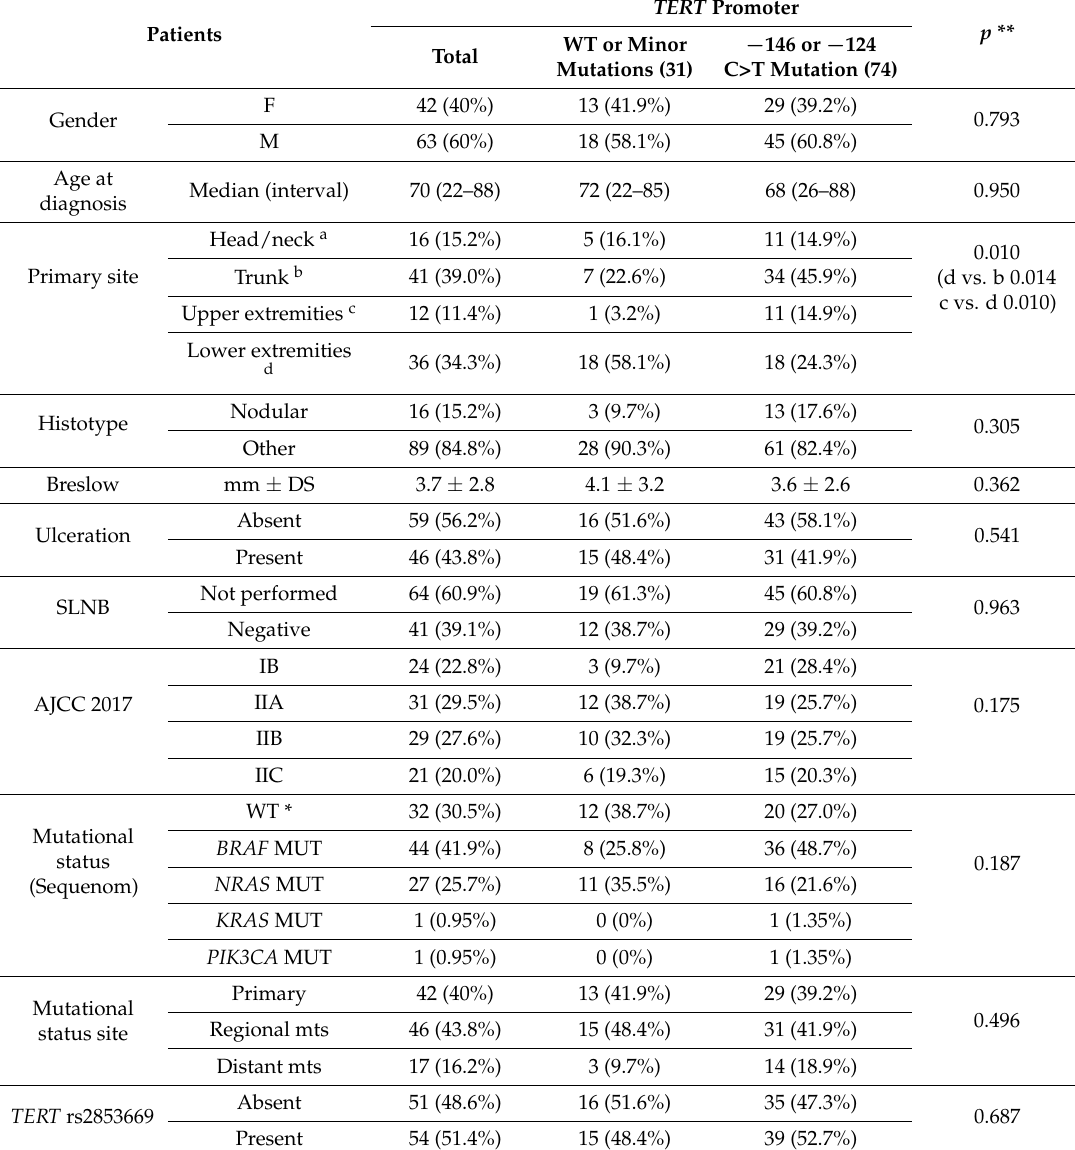
Table 3. Clinical characteristics based on TERT promoter